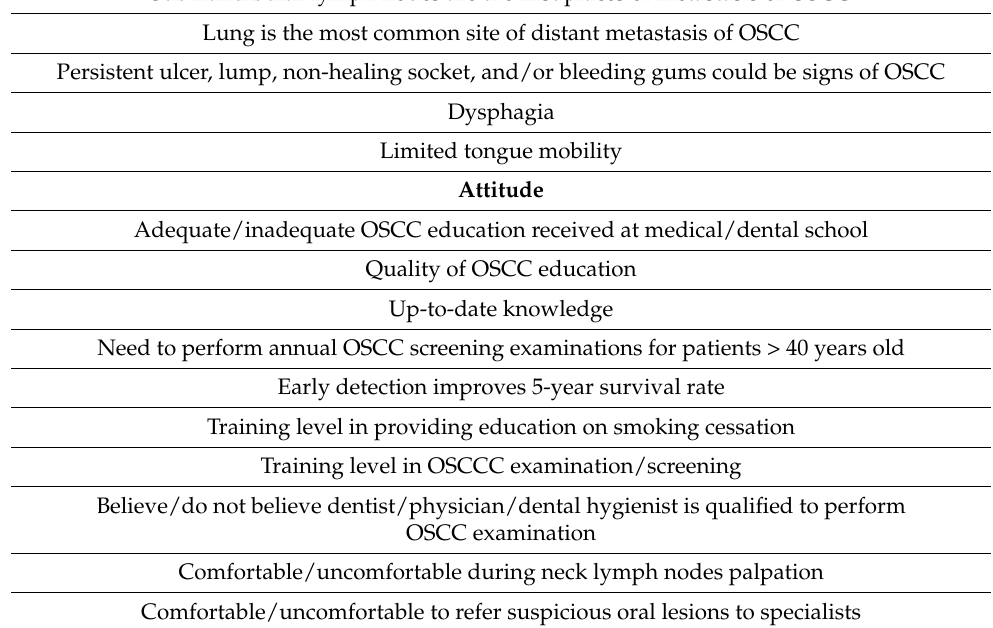
Table 2. Cont . Submandibular lymph nodes are the first places of metastasis of OSCC Lung is the most common site of distant metastasis of OSCC Persistent ulcer, lump, non-healing socket, and/or bleeding gums could be signs of OSCC Dysphagia Limited tongue mobility Attitude Adequate/inadequate OSCC education received at medical/dental school Quality of OSCC education Up-to-date knowledge Need to perform annual OSCC screening examinations for patients > 40 years old Early detection improves 5-year survival rate Training level in providing education on smoking cessation Training level in OSCCC examination/screening Believe/do not believe dentist/physician/dental hygienist is qualified to perform OSCC examination Comfortable/uncomfortable during neck lymph nodes palpation Comfortable/uncomfortable to refer suspicious oral lesions to specialists Confident/non-confident in diagnosis of OSCC from clinical appearance Patients’ knowledge level about risk factors Should/should not inform patients about findings Comfortable/uncomfortable to perform biopsy Advise/do not advise patients with suspicious oral lesions Need of continuous education in the future Adequate/inadequate preparation to explain the risks of tobacco/alcohol use